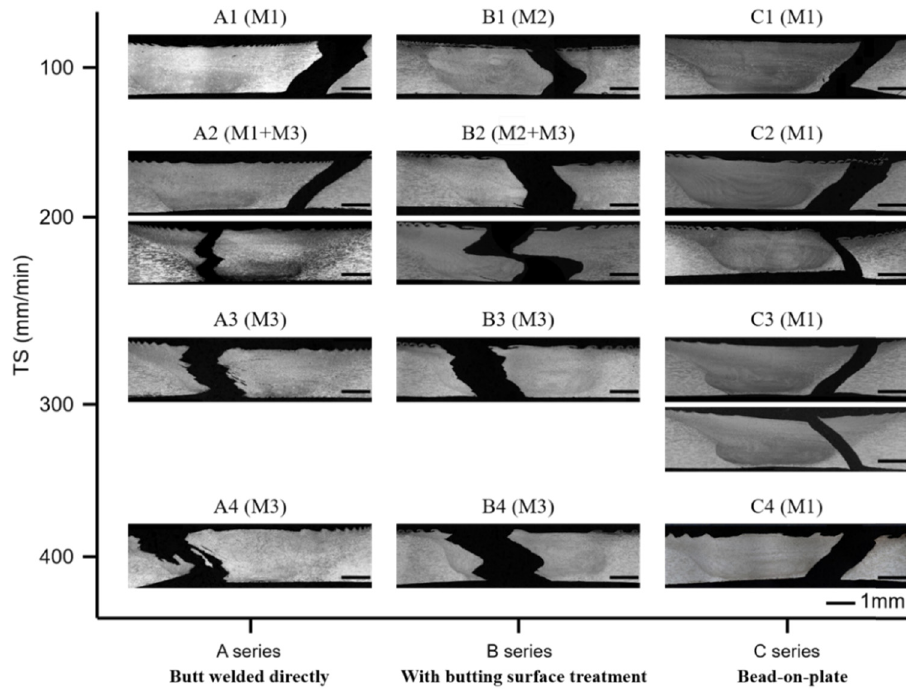
Figure 9: Summary of fracture modes corresponding to each welding condition.